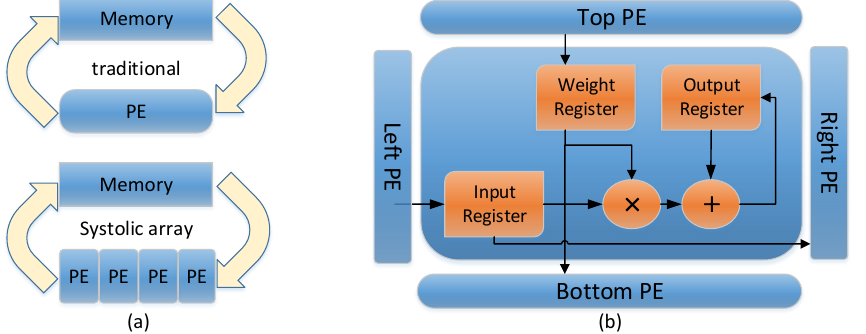
Figure 4. PE structures. ( a ) Traditional computing model vs. systolic array model. ( b ) The structure of PE in systolic